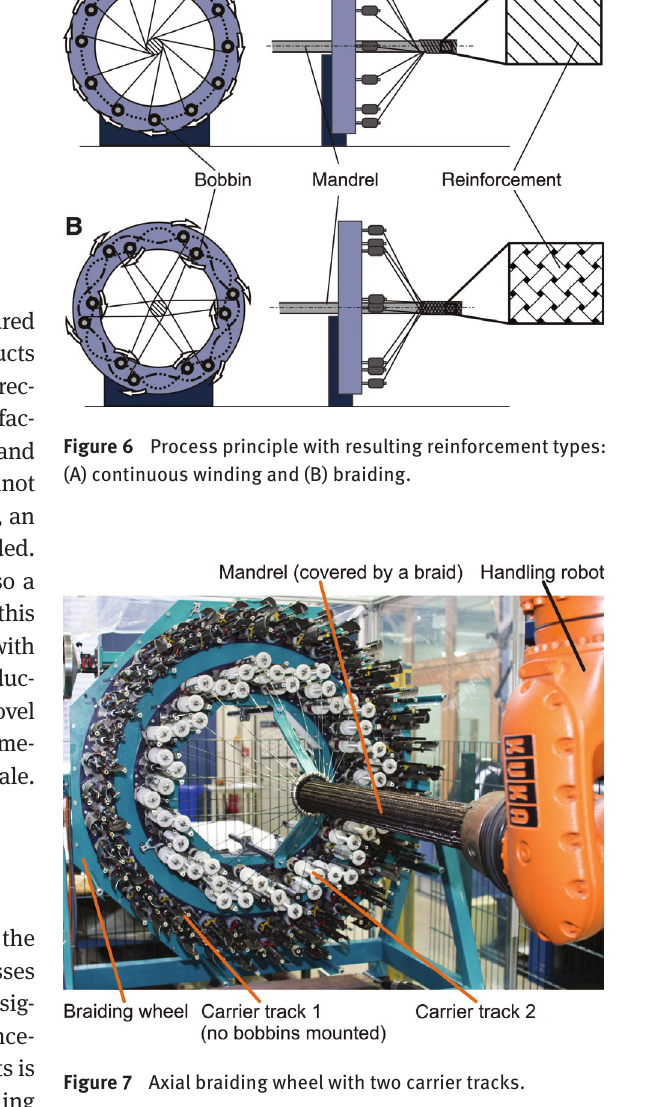
Figure 7 Axial braiding wheel with two carrier tracks.